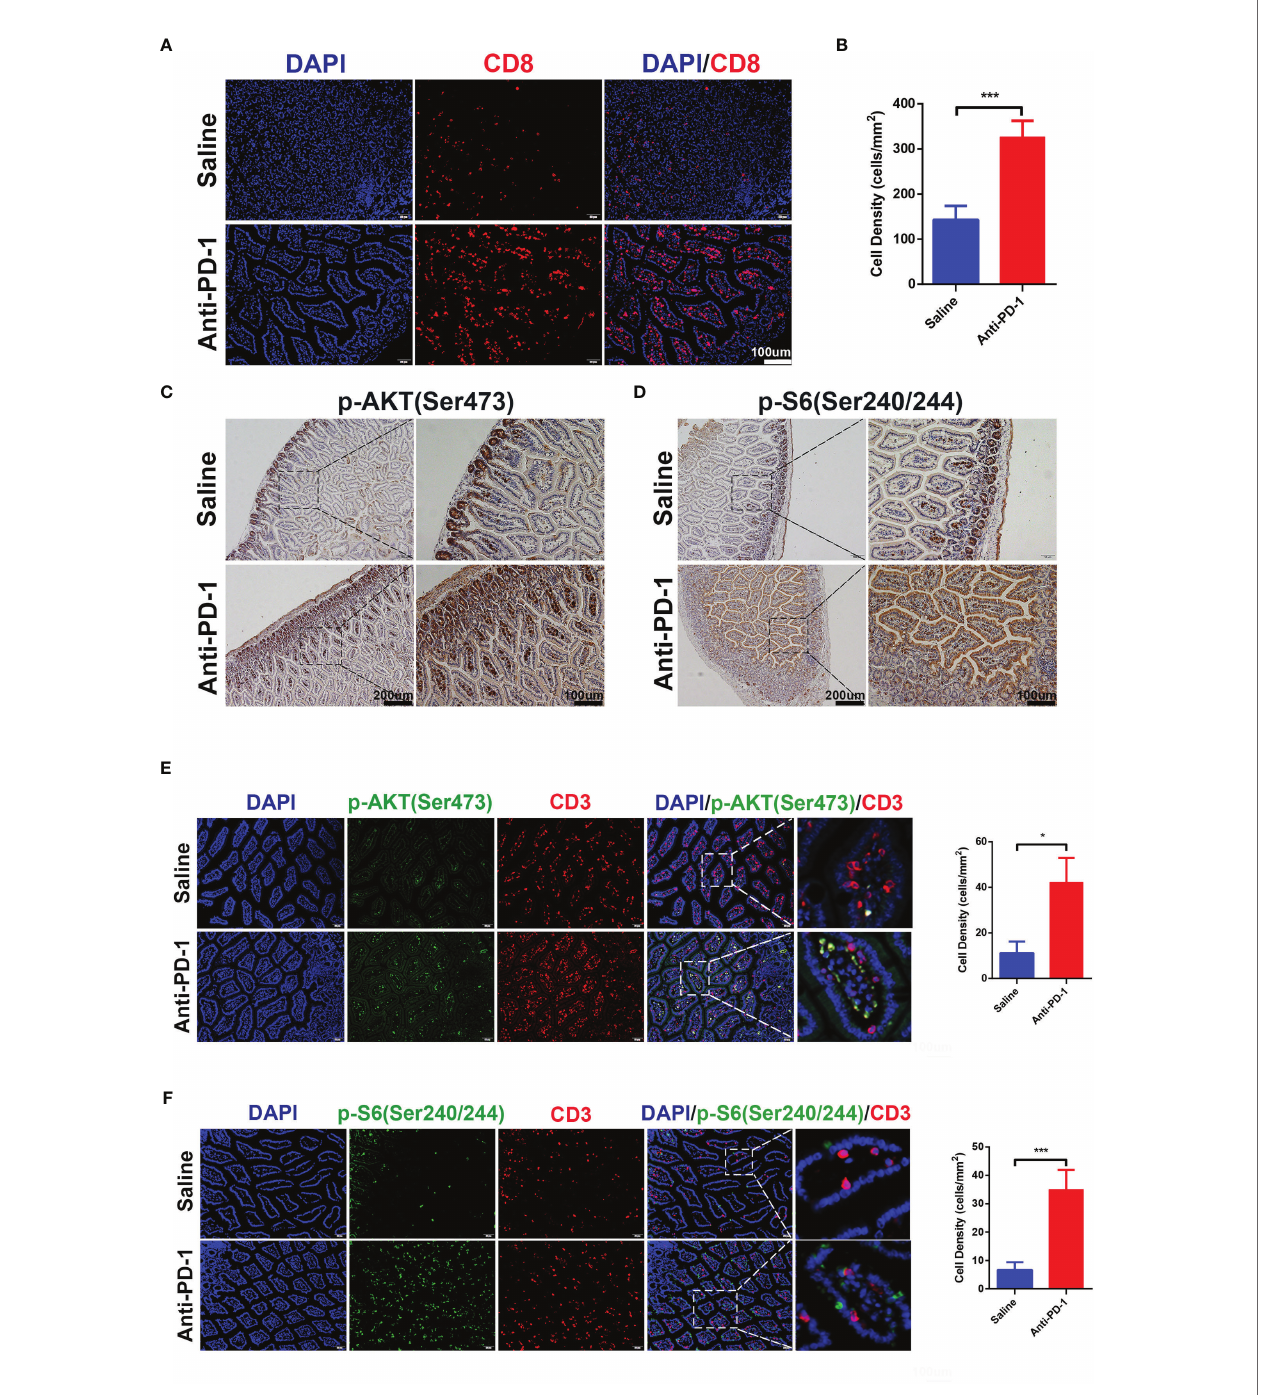
FIGURE 3 | CD8 + T cells in fi ltration and activation of PI3K-AKT-mTOR pathway were induced by anti-PD-1 immunotherapy. (A) Immuno fl uorescence staining showed the in fi ltration of CD8 + T cells in colon. CD8 is shown in red and DAPI in blue. Scale bar 100 m m. (B) The densities of CD8 + T cells in each group were quanti fi ed, the results were presented as mean ± SD (n=4), *** p < 0.001. (C) Phosphorylation of AKT (Ser 473) was detected by IHC staining. Scale bar 200 m m. (D) Phosphorylation of S6 Ribosomal Protein (Ser 240/244) was detected by IHC staining. Scale bar 200 m m. (E) Double immuno fl uorescent staining with CD3 and phosphor-AKT (Ser 473) antibodies counterstained with DAPI on FFPE colon sections. CD3 is shown in red, phosphor-AKT (Ser 473) in green, and DAPI in blue. Scale bar 100 m m. (F) Double immuno fl uorescent staining with CD3 and phosphor-S6 Ribosomal Protein (Ser 240/244) antibodies counterstained with DAPI on FFPE colon sections. CD3 is shown in red, phosphor-S6 Ribosomal Protein (Ser 240/244) in green, and DAPI in blue. Scale bar 100 m m. * p <